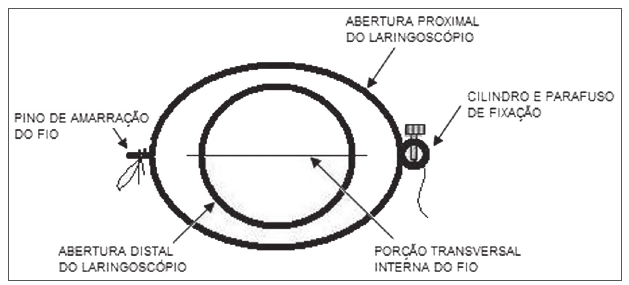
Figura 2. Vista interior do laringoscópio e do fio horizontal.